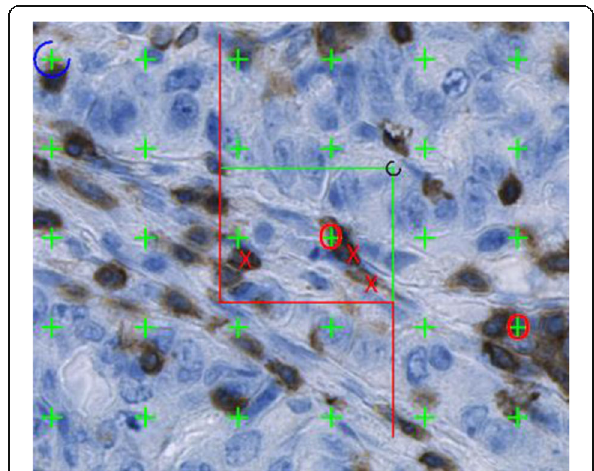
Fig. 4 Field of vision in a CD3-stained section magnified ×40. The density estimation was performed using the 2D unbiased counting frame with left and bottom edges, and their extensions, serving as exclusion lines (red), and with the upper and right edges of the frame as inclusion lines (green). Cell profiles were counted when completely inside the counting frame or partly inside the frame, provided that they did not touch the exclusion lines or their extensions. Thus, three cell profiles were counted (red crosses). The area fraction estimation was performed using the point grid. Points hitting CD3 positive cells = 2 (red ring) and points hitting tumor = 30, giving an area fraction of 0.07 in this field of